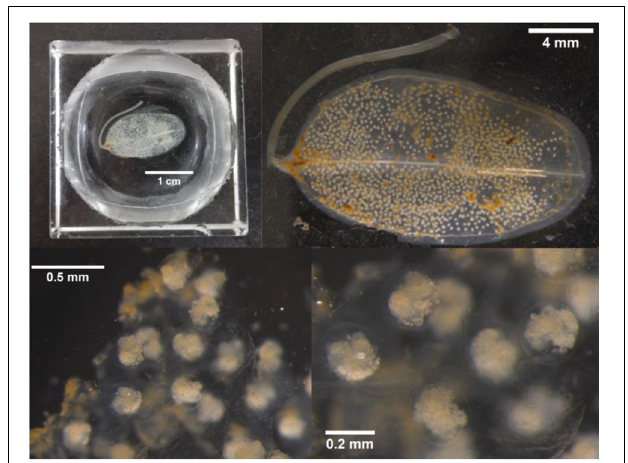
FIGURE 2 | The eggs of Stethojulis trilineata attaching on the leaf of Halophila ovalis with different scales collected from Liusha Bay, Guangdong